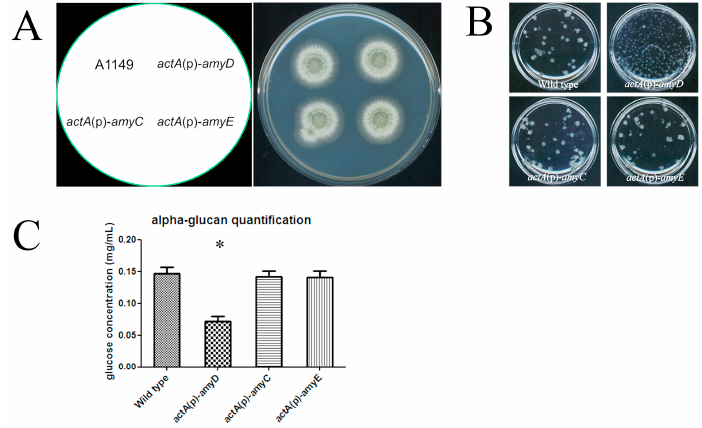
Figure 2. Overexpression of amyC and amyE does not affect significantly α -glucan accumulation. ( A ) 10 5 freshly harvested conidia of each strain were inoculated on complete medium and the plates were incubated at 30 °C for 48 h. All constructed strains showed the wild type colony phenotype on solid medium; ( B ) a large number (5 × 10 7 ) of freshly harvested conidia were inoculated in flask with 20 mL complete medium, then the flask was incubated at 30 °C, 150 rpm overnight. Only actA (p)- amyD formed tiny colonies; ( C ) A large number (2 × 10 7 ) of spores of each strain were inoculated in 100 mL complete medium. Samples were grown in flasks at 30 °C with 150 rpm for 24 h. α -glucan was extracted from 1 mg dry cell wall, and then digested to glucose and quantified by an anthrone assay. Results represent the mean of three independent quantification tests with duplicates each time ± standard deviation. The data for each strain were compared with wild type (column 1) individually by Mann Whitney U test. Significant difference ( p < 0.05) is indicated by asterisks.